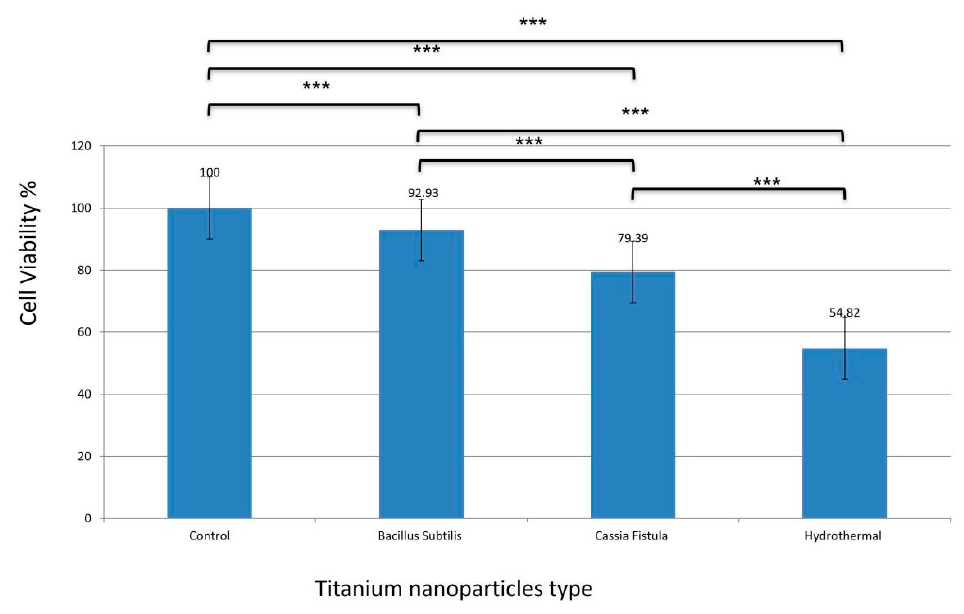
Figure 12. Cell Viability (%) of titanium nanoparticles formed by Bacillus subtilis , Cassia fistula and titanium tetrachloride at 31st day in comparison to control group (*** p < 0.001, error bars = S.E).